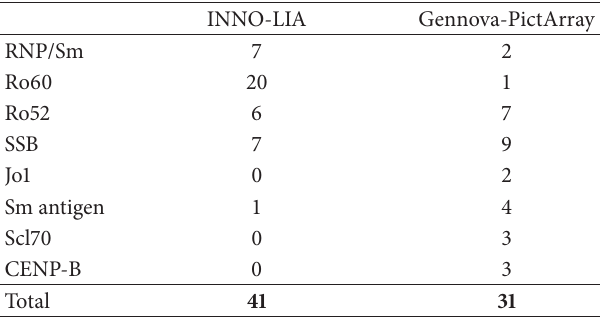
Table 3: The number of ambiguous (+/ − ) results using immunolog- ical assays in the connective tissue disease